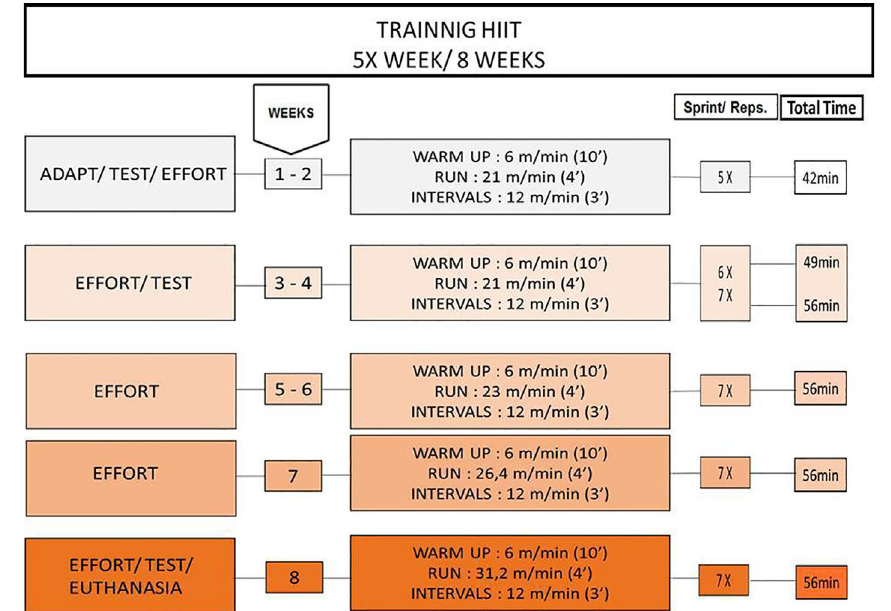
Figure 1 - Training Protocol used in the present study.